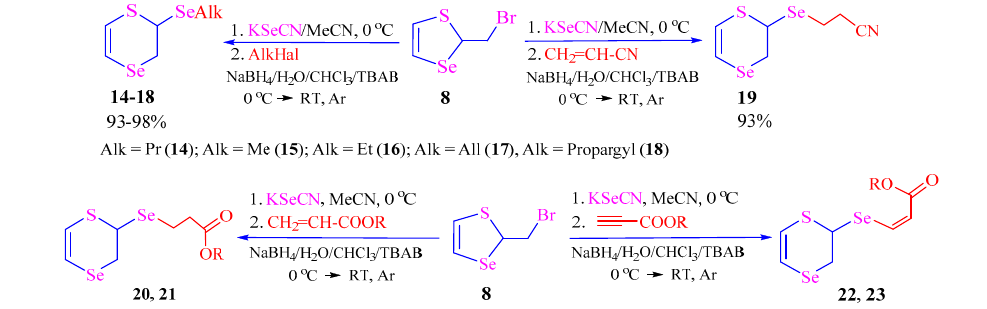
Table 1. The synthesis of the products 14–23 based on thiaselenole 1 , potassium selenocyanate and electrophilic reagents under phase transfer catalysis conditions.